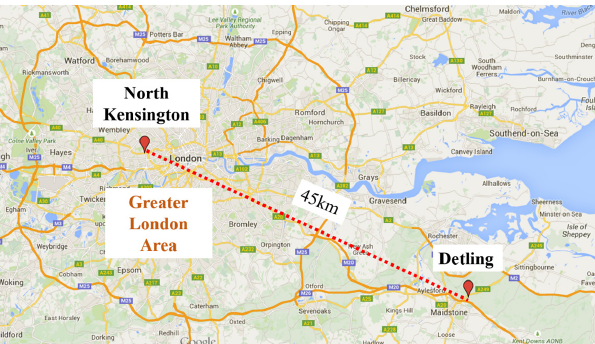
Figure 1. Geographical locations of the sampling sites (i.e., North Kensington and Detling) in this study. The region circled by the M25 motorway is the greater London area. The map is adapted from Google